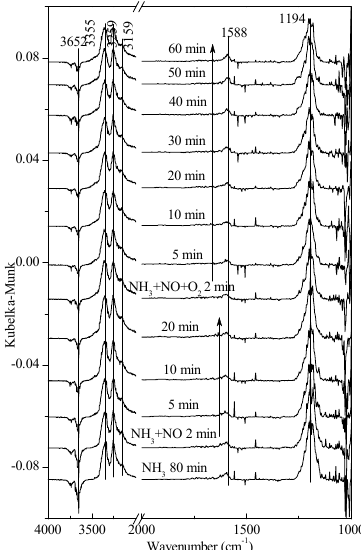
Figure 7. In situ DRIFTS spectra of NH 3 +NO+O 2 pre-adsorption transient reaction at 250 °C over 1 wt. %V 2 O 5 -0.2CeO 2 /TiO 2 -ZrO 2 catalysts recorded as a function of time.